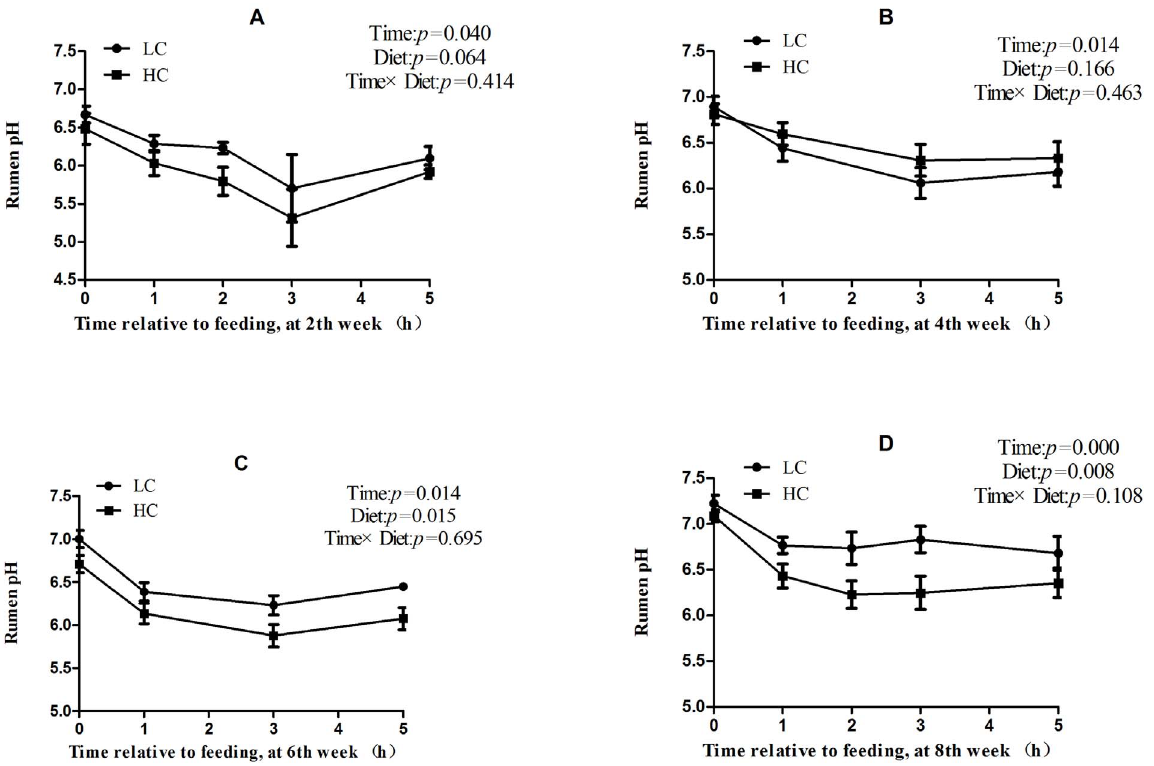
Figure 1. Rumen fluid pH values. Data were analyzed for differences due to diet, time, and their interactions by Univariate using the General Linear Models of SPSS 11.0 for Windows (StatSoft Inc, Tulsa, OK, USA). Values are mean 6 standard error of the mean